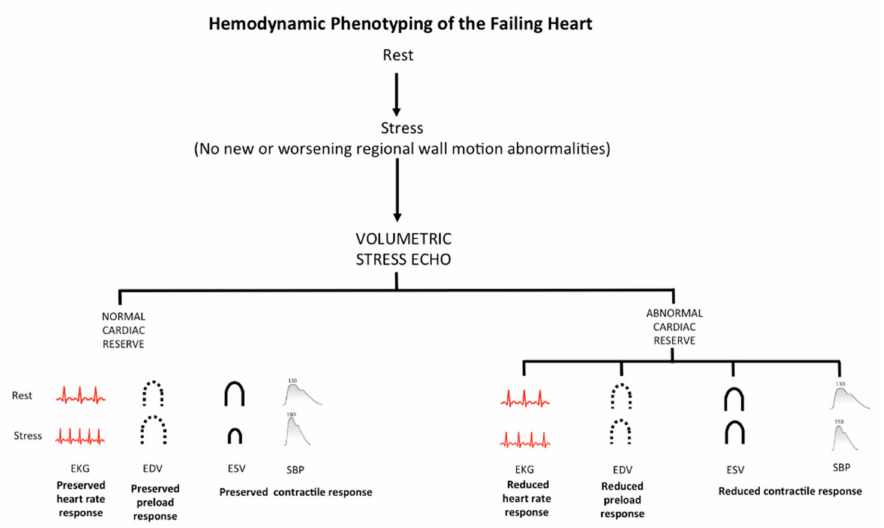
Figure 3. Hemodynamic phenotyping of the failing heart by stress echocardiography. SE based on regional wall motion abnormalities easily allow to identify inducible myocardial ischemia as regional wall motion abnormalities often associated with abnormal cardiac reserve (upper panel). However, a normal response of regional wall motion can also be associated with abnormal cardiac reserve, possibly due to the isolated or combined presence of distinct phenotypes: reduced heart rate response with chronotropic incompetence; “reduced preload response” with impaired preload reserve; “reduced contractile response” with blunted LVCR. Each phenotype must be identified for effective personalized